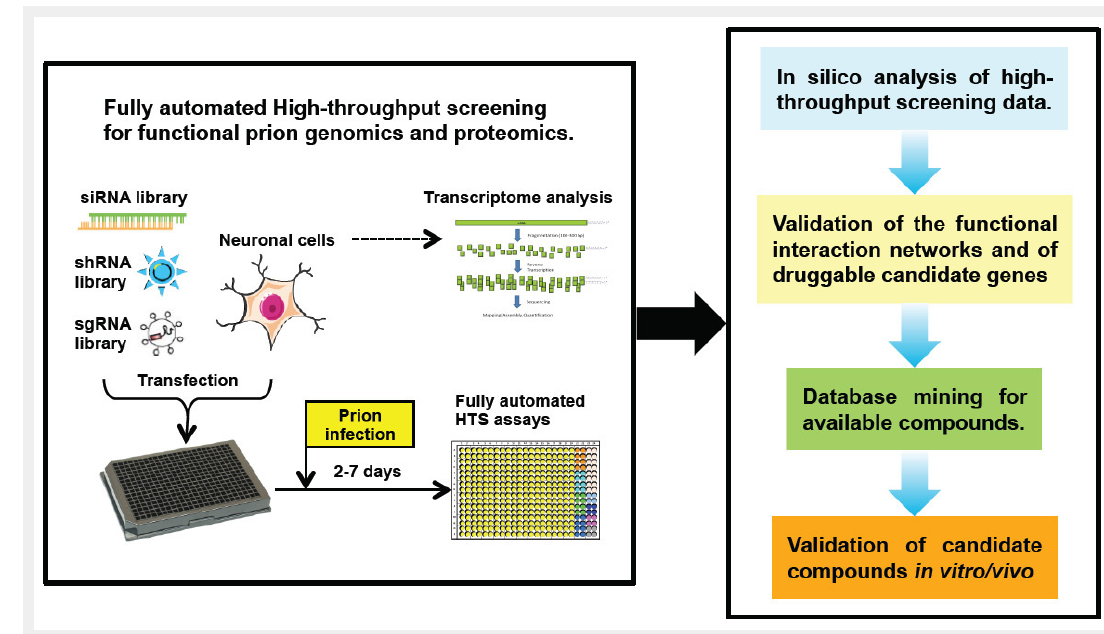
Figure 2: Proposed new strategies for high throughput small RNA screens to discover cell signalling mechanisms and novel therapeutic target for prion disease. HTS = high throughput screening; sgRNA = single guide RNA; shRNA = short hairpin RNA; siRNA = small interfering RNA